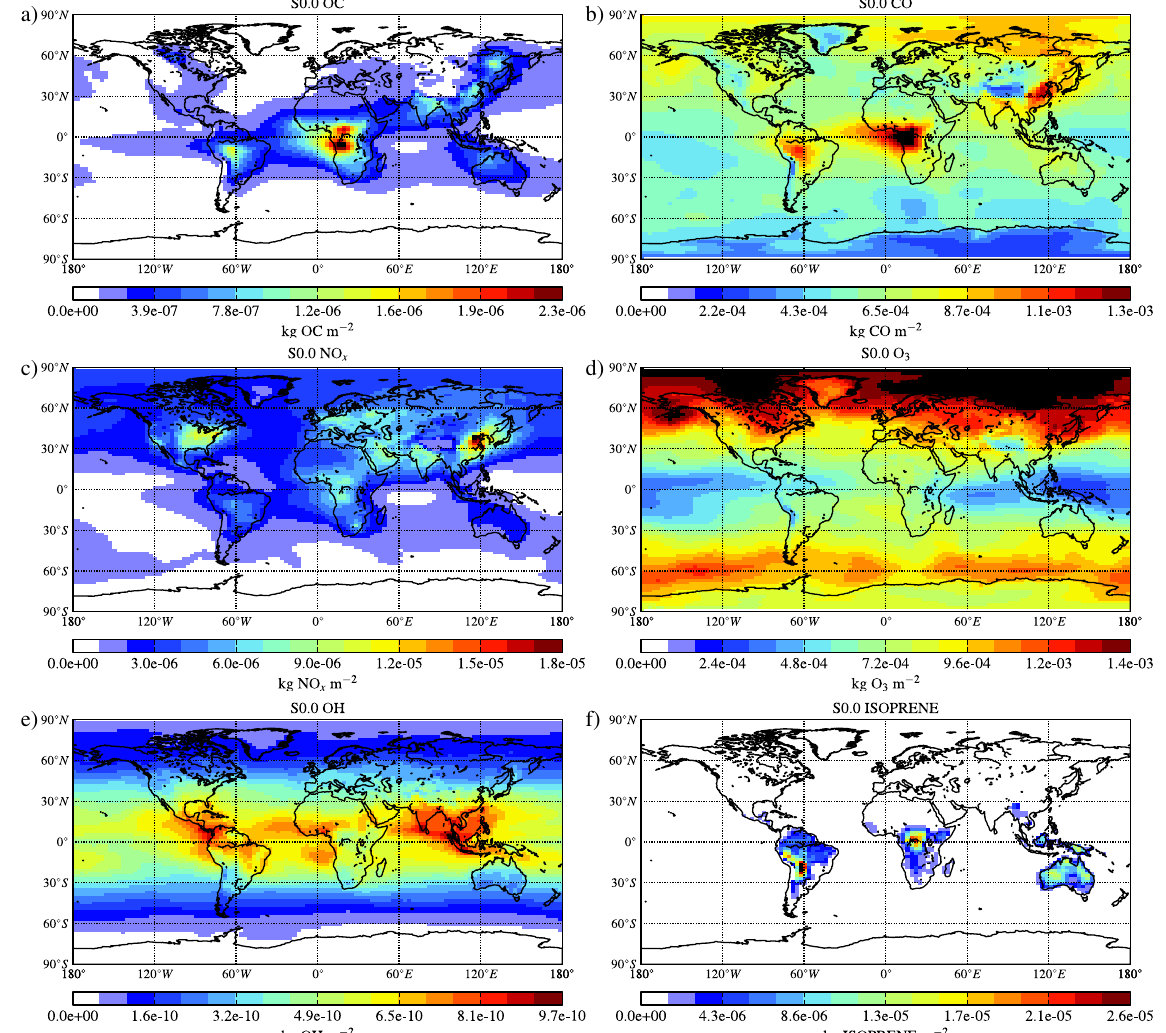
Figure 6. Calculated annual mean tropospheric load in (Kgm − 2 ) of selected species for the base case scenario (S0.0). Areas with black exceed the maximum value of the color